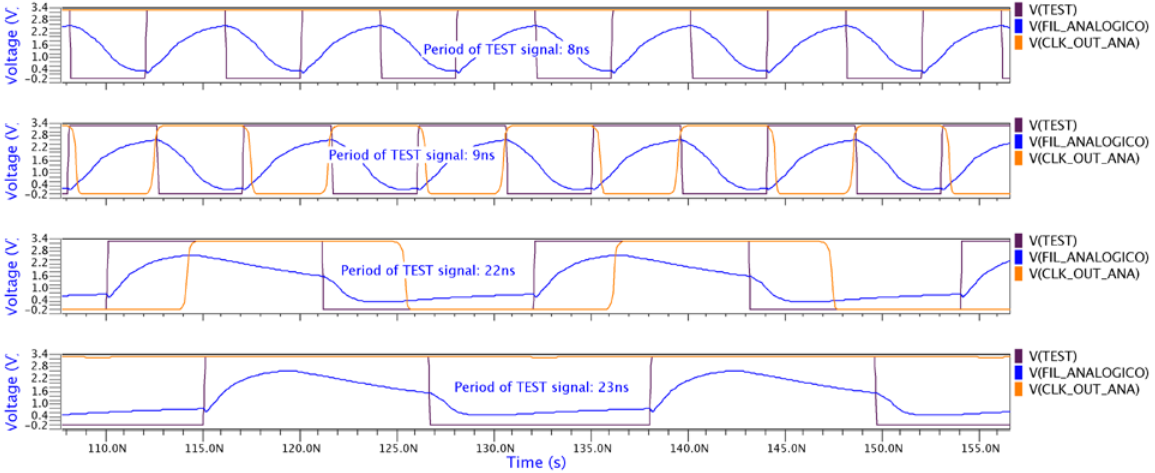
Figure 12. Timing behavior of the analog sensor.